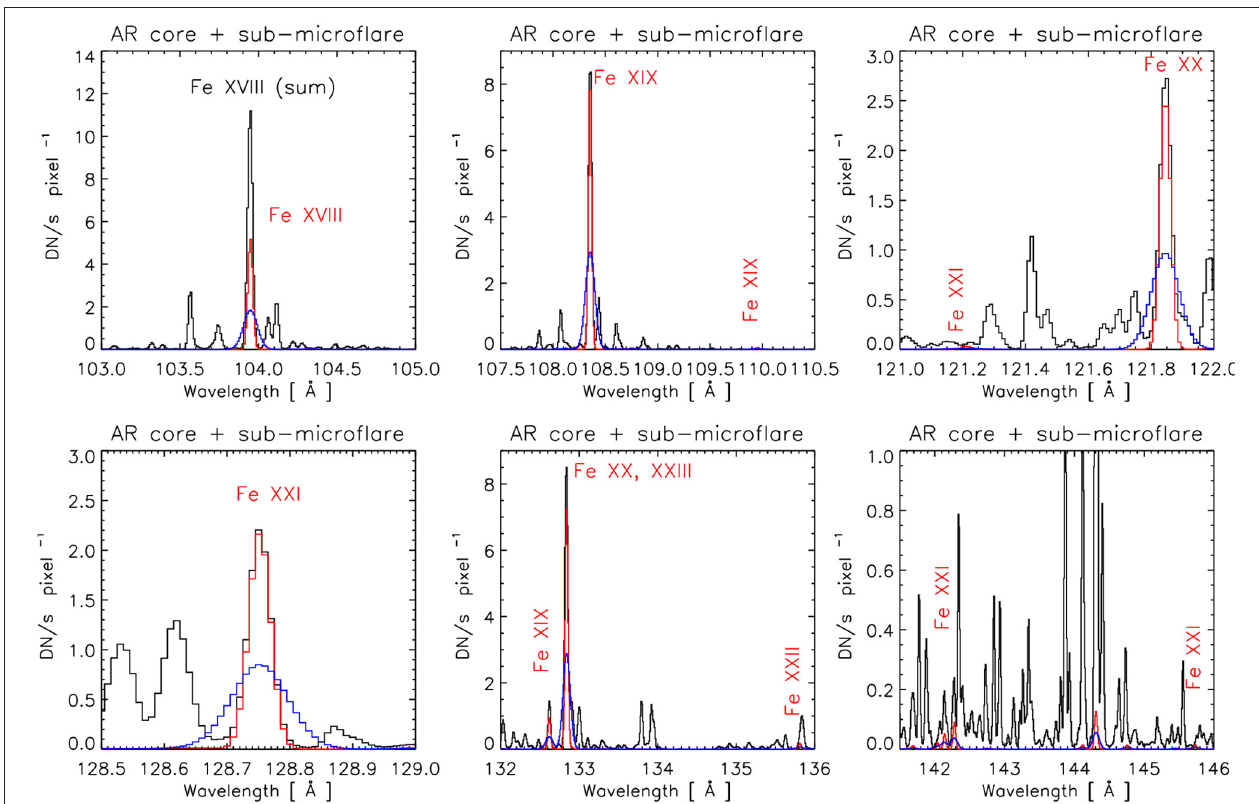
FIGURE 7 | Simulated SXR count rates (1 ′′ pixel) for a sub-A class microflare of 6.7 MK (red spectrum). The black spectrum is the sum of the microflare and active region core. The blue spectrum shows the hot emission from the sub-A class microflare but with an additional broadening of 200 km s − 1